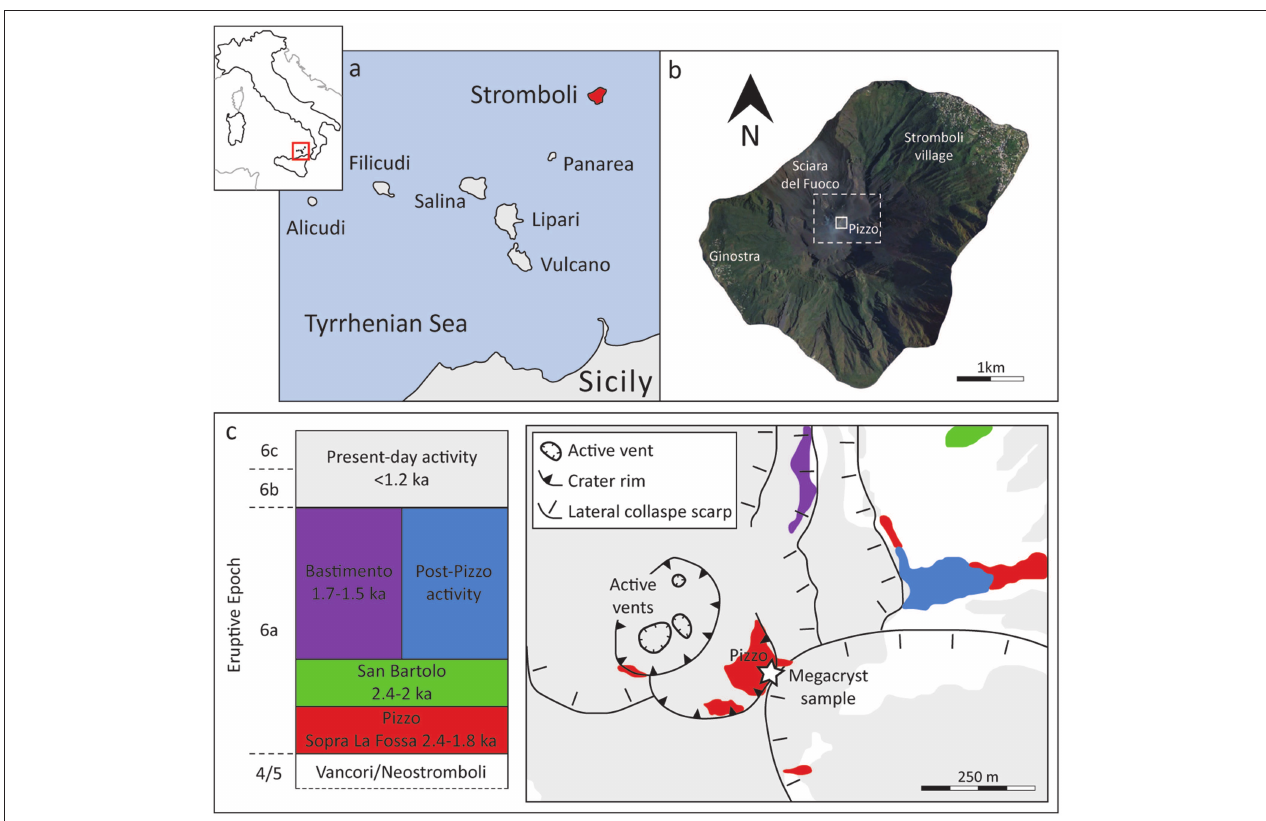
FIGURE 1 | (a) Location of the island of Stromboli in the Aeolian archipelago, Sicily Province, southern Italy. (b) Aerial view of Stromboli from Google Earth, outlining summit sample area (Pizzo; solid white square). Dashed white inset denotes location of the geological map in (c). (c) Simplified geological map of the Stromboli summit area (modified after Petrone et al., 2018). Legend includes age of eruptive units. The Post-Pizzo activity lacks absolute age constraints but is considered coeval to the Bastimento lavas on the basis of geochemical characteristics ( Francalanci et al., 2013). Sampling site is marked with a white star on the map: the clinopyroxene megacrysts were collected from the partially collapsed Pizzo-o-Sopra-la-Fosa (Pizzo) scoria cone, which represents the best viewpoint for observing the Present-day activity at the summit of Stromboli volcano ( Francalanci et al.,